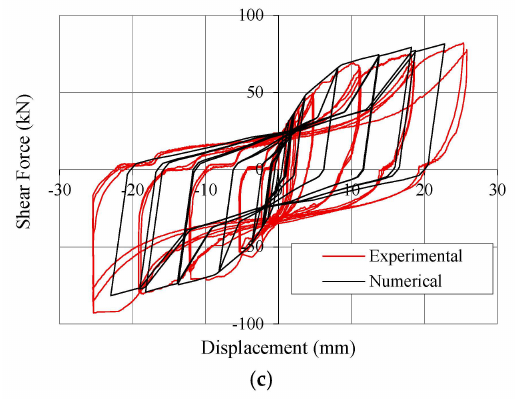
Figure 12. Hysteresis cycles of shear wall: ( a ) Top displacement vs. lateral force; ( b ) Displacement at hold-down vs. lateral force; and ( c ) Relative displacement at vertical joint vs. lateral force.